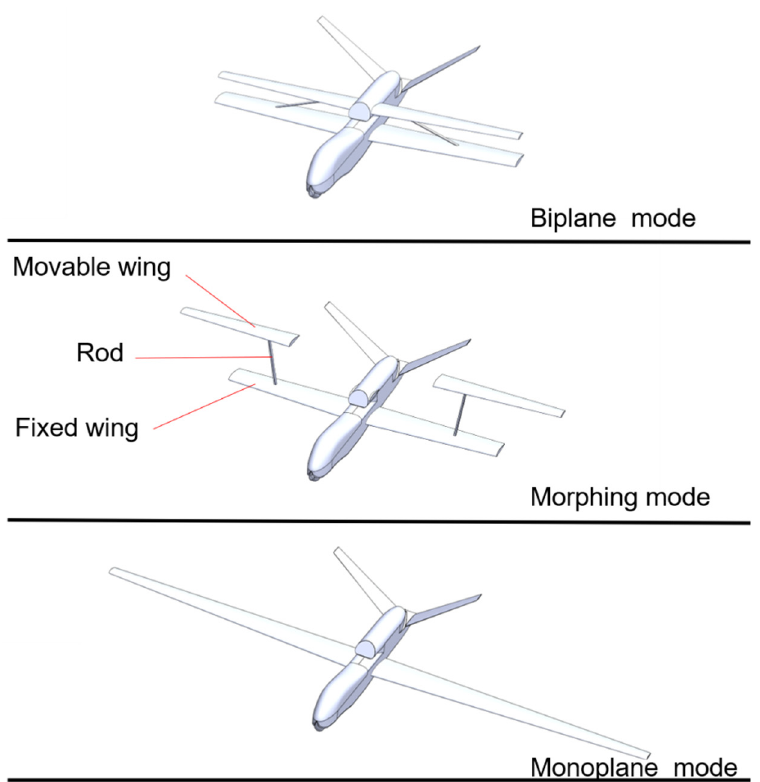
Figure 1. The morphing mode of the mono-biplane aerodynamics-driven morphing aircraft. The connecting rod of the mono-biplane aerodynamics-driven morphing aircraft is articulated with the two wings. The morphing movement of the wing can be decomposed into the revolution of the connecting rod around the fixed wing and the rotation of the movable wing around the connecting rod. Ailerons are provided both inside and outside of the hinge on the movable wing. The direction and magnitude of the lift vector of the movable wing are changed by the deflection control of the ailerons, which drives the revolution of the movable wing and the connecting rod. When the aileron of the movable wing deflects upward, the lift is reduced, and the movable wing can be controlled to move downward. When the aileron of the movable wing deflects downward, the lift increases, and the movable wing can be controlled to move upward. At the same time, when the deflections of the two ailerons are not synchronized, the rolling moment will be generated to adjust the rotation angle of the movable wing around the rod. In the process of morphing, through the coordination of the two rotations, the movable wing, and the fixed wing can be kept parallel or slightly inclined to help the rotation. After rotating to the designated position, the movable wing and the fuselage or the movable wing and the fixed wing are locked, and morphing is completed. The whole morphing process is shown in Figure 2. In this morphing process, each movable wing adds two degrees of freedom of rotation and revolution, while the aileron provides two control rudders, forming a dual-input dual-output control system as shown in Figure 3. In the aerodynamic control scheme, the lift and gravity of the movable wing mostly offset each other, and the connection structure only needs to transmit the drag of the movable wing and the torque caused by the drag, which can effectively reduce the strength and rigidity requirements of the connecting rod and the hinge and reduce the structural weight.